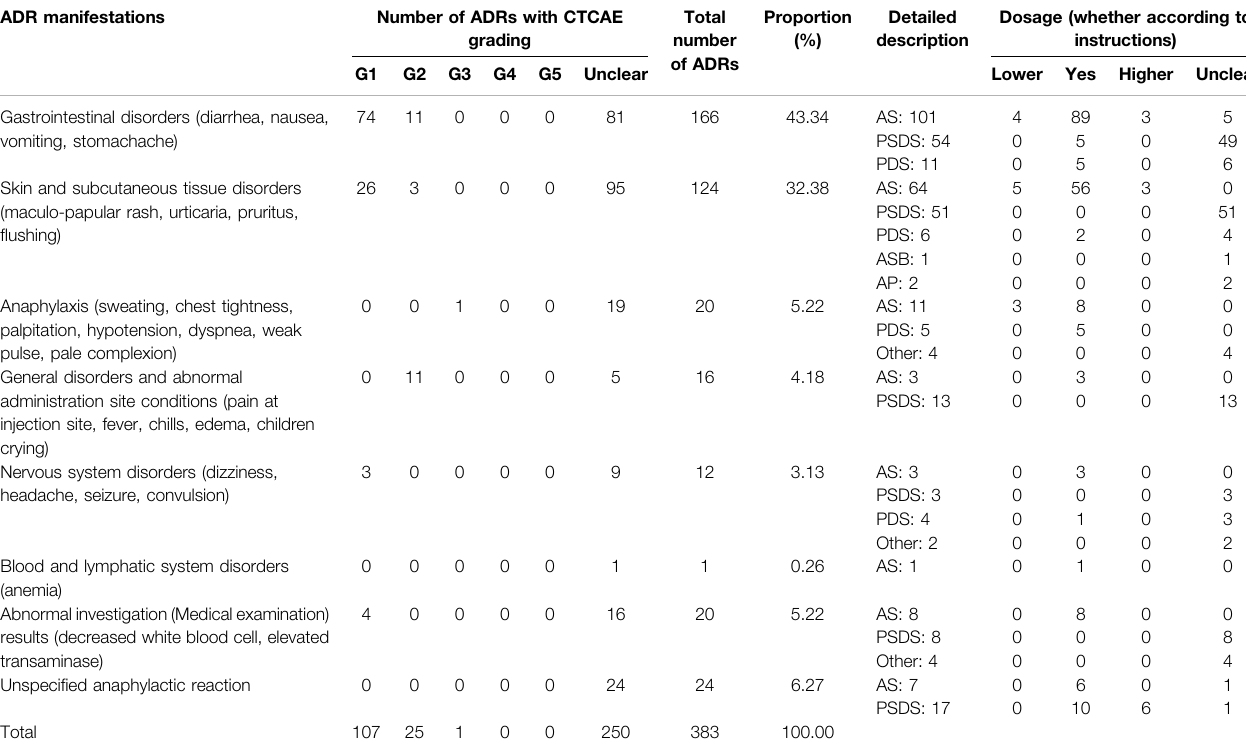
TABLE 3 | Manifestations and severity of ADRs of andrographolide derivative injections reported in the included RCTs, non-RCTs and case series. ADR manifestations Number of ADRs with CTCAE